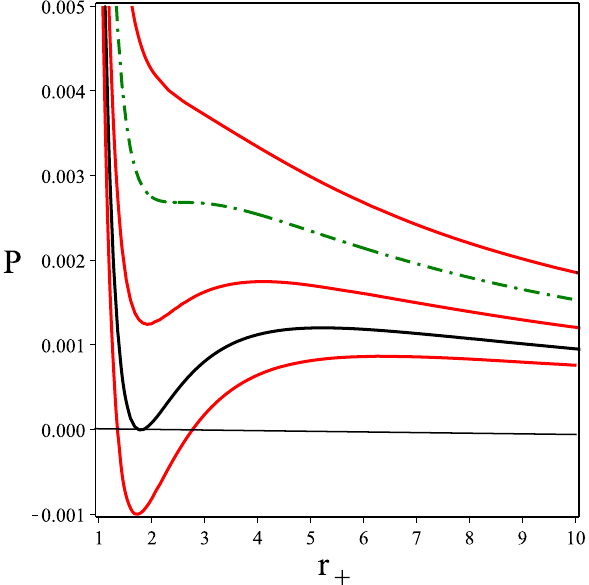
Fig. 8 The behavior of P in terms of r + for Q = 1 , T = 0 . 045 , 0 . 0385 , 0 . 034 , 0 . 0269 , 0 . 023